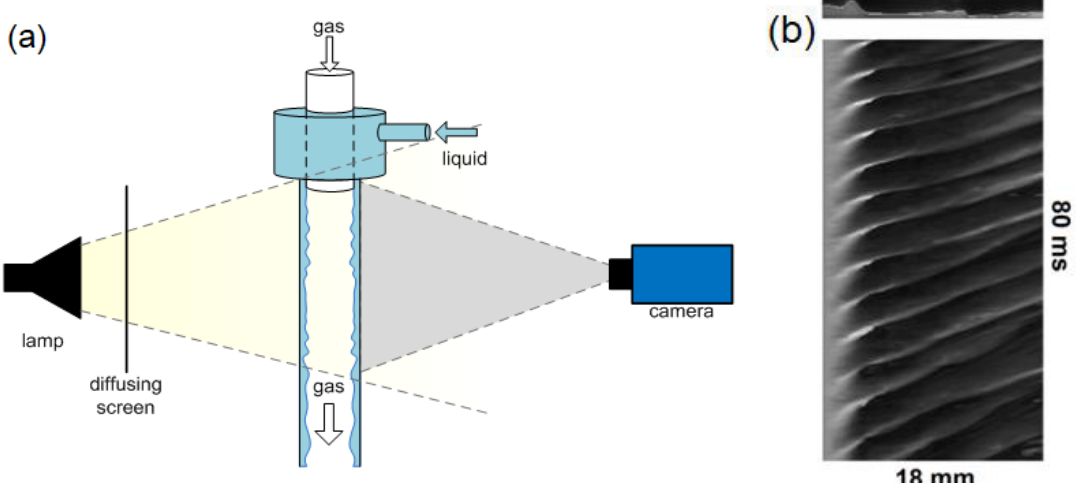
Figure 1. ( a ) Scheme of the inlet and layout of the camera and the illumination lamp for the shadow method; ( b ) instantaneous image of the film profile on one wall of the pipe and a fragment of a spatiotemporal matrix of film thickness.